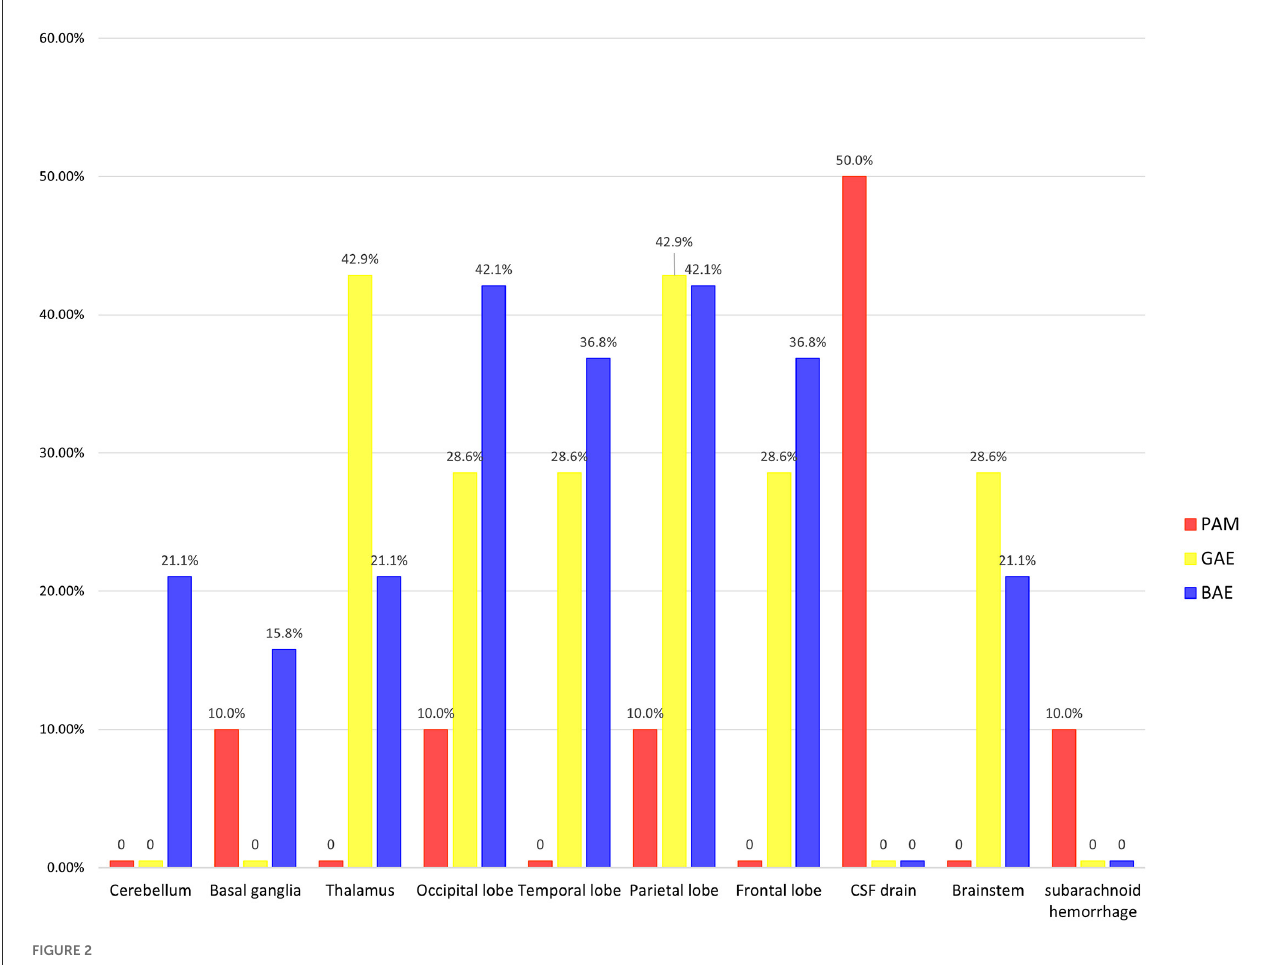
FIGURE2 Sites of infection of three free-living amoebae infections in China.